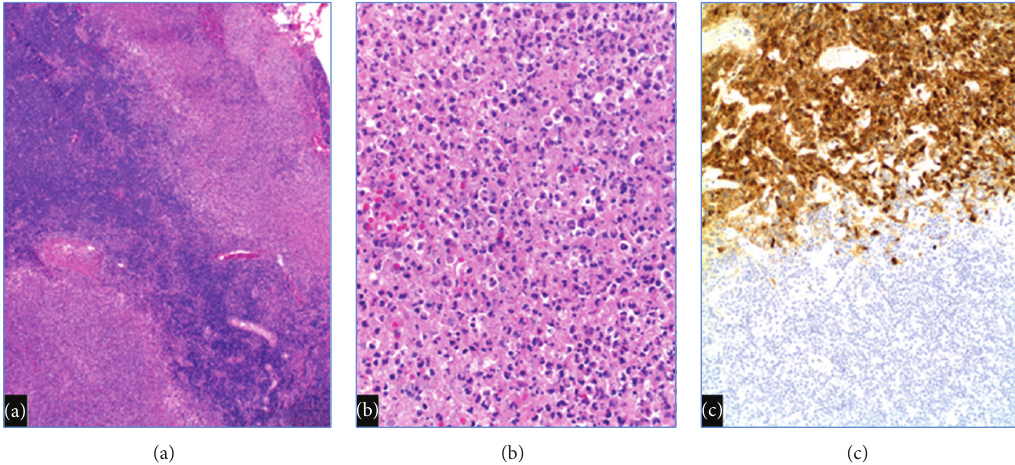
Figure 3: HSV infections when superimposed on low grade B-cell lymphomas show (a) well-demarcated areas of necrosis (Reference case) 40x magnification, (b) necrosis containing HSV viral inclusions (Reference case) 200x magnification, and (c) numerous viral inclusions only in the necrotic areas by HSV immunohistochemistry (Reference case) 100x